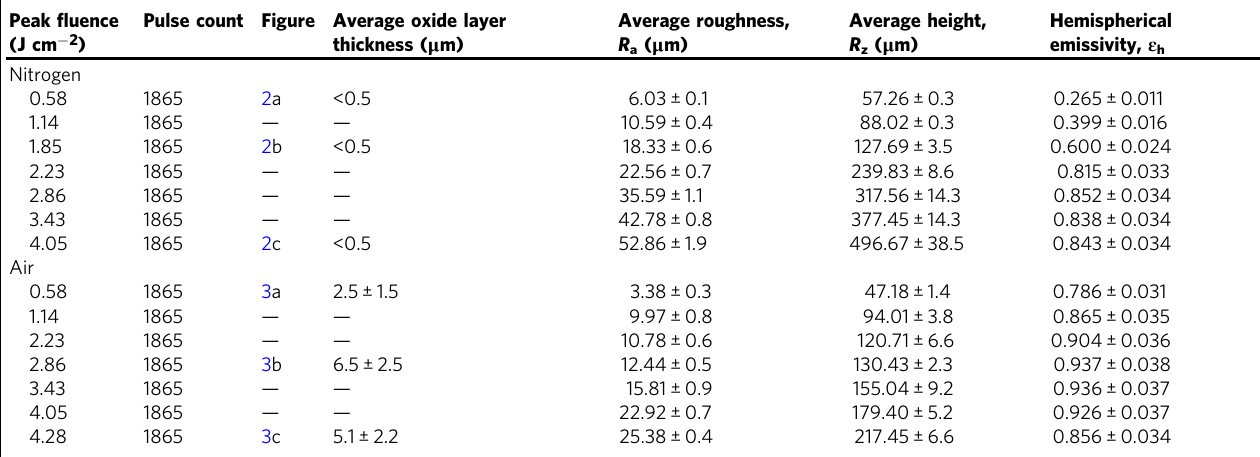
Table 1 Laser processing parameters with corresponding surface roughness parameters and emissivity for FLSP samples processed in either air or